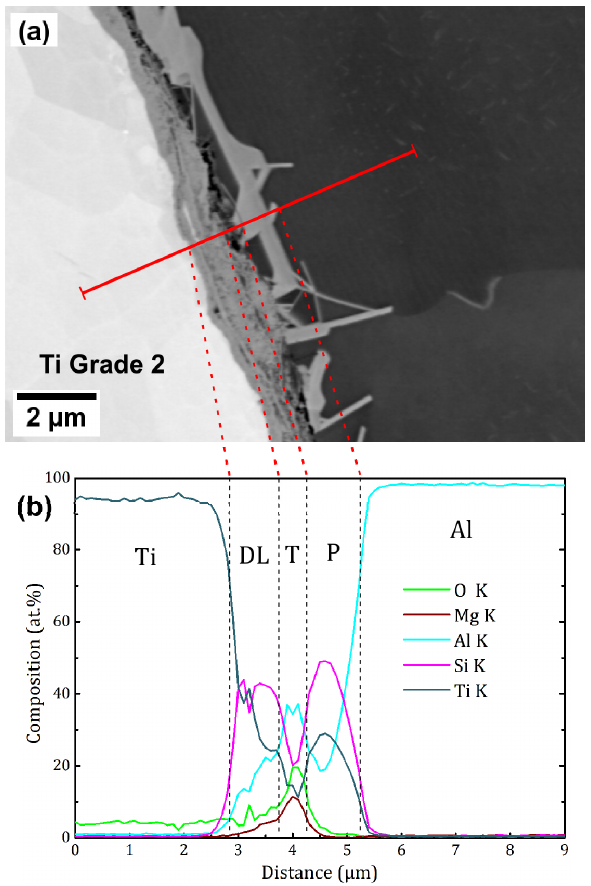
Figure 5. ( a ) A detail of the Ti Grade 2/Al6061 interface. ( b ) A composition profile across the interface with major regions labeled: Ti wire (Ti), Al6061 matrix (Al), diffusion layer (DL), precipitate (P) and transition layer with Mg segregation (T).